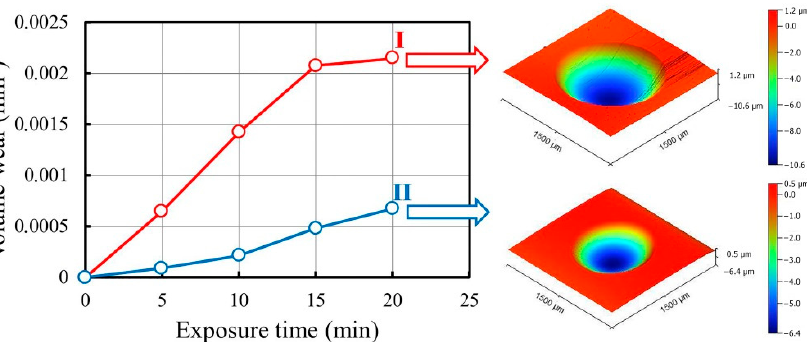
Figure 7. Dependencies of the abrasion volume on the test time for a not-processed sample (I) and a sample after combined treatment (II).